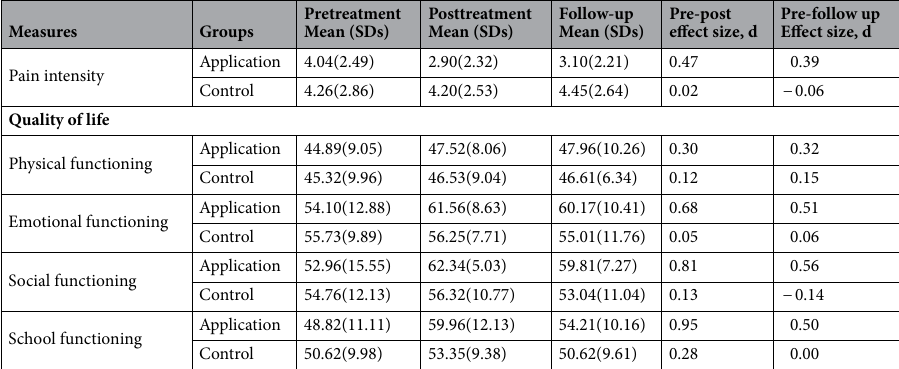
Table 2. Pain intensity and Quality of Life Dimensions, Means (SDs) and Effect sizes (Cohen’s d).